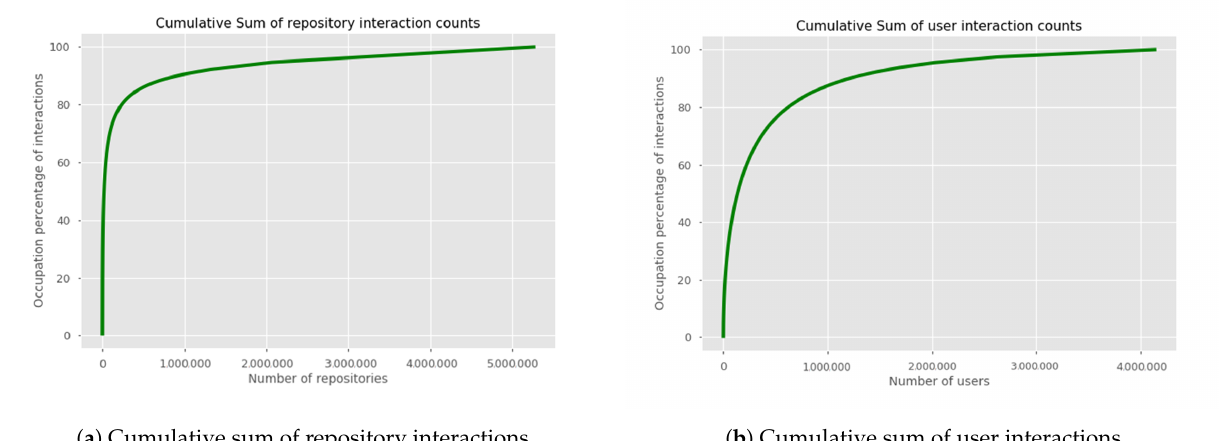
Figure 5. Statistics of the number of games and number of users.